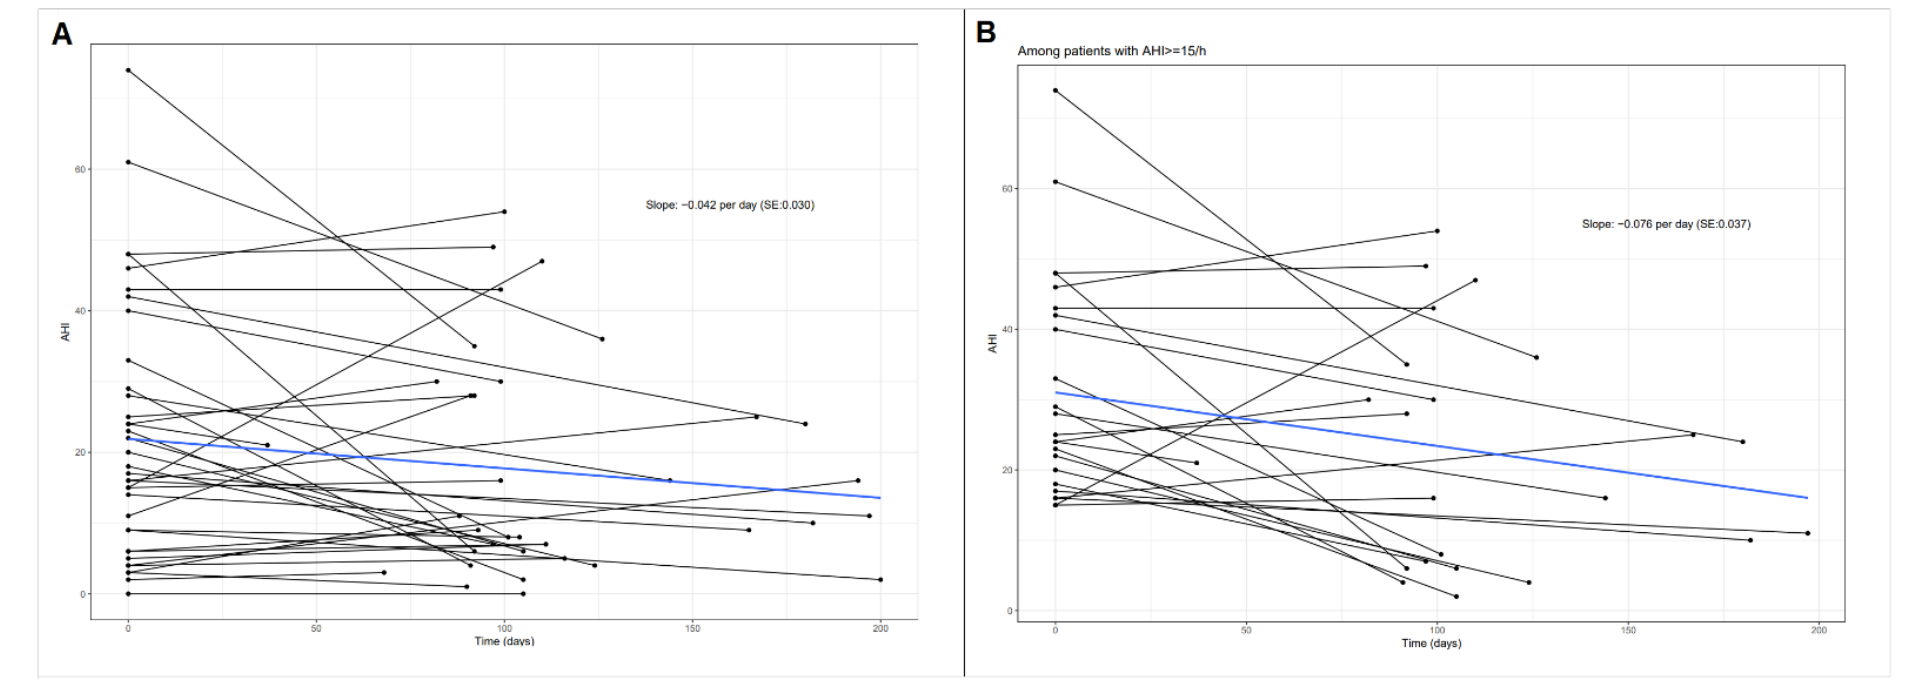
Figure 3. Progression of apnea-hypopnea-index (AHI) during follow-up in 34 patients. ( A ) In all patients ( p = 0.077). ( B ) In patients with baseline-AHI ≥ 15 ( p = 0.013).